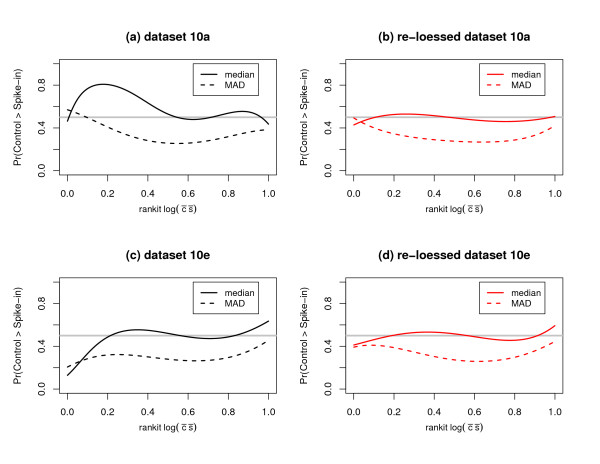
A diagnostic plot to assess, as a function of signal intensity, whether or not the underlying distributions for the control and spike-in expression values share the same center and scale. The x-axes correspond to the rankit (i.e., rank of valuetotal#of values+1
 MathType@MTEF@5@5@+=feaafiart1ev1aaatCvAUfKttLearuWrP9MDH5MBPbIqV92AaeXatLxBI9gBaebbnrfifHhDYfgasaacH8akY=wiFfYdH8Gipec8Eeeu0xXdbba9frFj0=OqFfea0dXdd9vqai=hGuQ8kuc9pgc9s8qqaq=dirpe0xb9q8qiLsFr0=vr0=vr0dc8meaabaqaciaacaGaaeqabaqabeGadaaakeaadaWcaaqaaiabbkhaYjabbggaHjabb6gaUjabbUgaRjabbccaGiabb+gaVjabbAgaMjabbccaGiabbAha2jabbggaHjabbYgaSjabbwha1jabbwgaLbqaaiabbsha0jabb+gaVjabbsha0jabbggaHjabbYgaSjabcocaJiabb+gaVjabbAgaMjabbccaGiabbAha2jabbggaHjabbYgaSjabbwha1jabbwgaLjabbohaZjabgUcaRiabigdaXaaaaaa@52A7@) of the log of the product of the expression means. The y-axes correspond the probability that the control samples will have a value greater than the spike-in sample; values for the median and the MAD (median absolute deviation) were considered. The horizontal solid gray line corresponds to a probability of 12
 MathType@MTEF@5@5@+=feaafiart1ev1aaatCvAUfKttLearuWrP9MDH5MBPbIqV92AaeXatLxBI9gBaebbnrfifHhDYfgasaacH8akY=wiFfYdH8Gipec8Eeeu0xXdbba9frFj0=OqFfea0dXdd9vqai=hGuQ8kuc9pgc9s8qqaq=dirpe0xb9q8qiLsFr0=vr0=vr0dc8meaabaqaciaacaGaaeqabaqabeGadaaakeaadaWcaaqaaiabigdaXaqaaiabikdaYaaaaaa@2E9E@. The probability that, for a randomly sampled probeset, the control samples will have a value greater than the matched spike-in samples was modeled as the logit of a 4thorder polynomial for rankit intensity. Solid (dashed) lines correspond to the logistic regression fits for the median (MAD). Diagnostic plots (a) and (c) indicate that, prior to re-loessing, the control and spike-in expression values were not equivalently centered and scaled for all signal intensities. Diagnostic plots (b) and (d) indicate that re-loessing the data provided control and spike-in expression values which were equivalently centered and but not equivalently scaled. Although loess correcting using only the set of true invariants can provide Stage II data which is adequately re-centered, issues pertaining to relative scale may remain and can invalidate the null distributions of commonly used two sample test statistics.